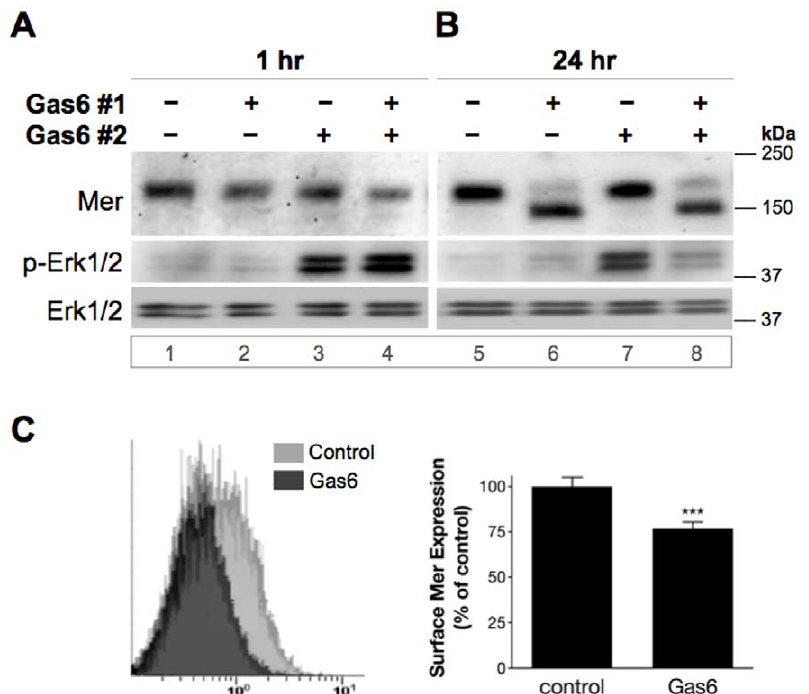
Figure 3. The Gas6-favored Mer glycoform is associated with altered downstream signaling and reduced surface expression. Jurkat cells were initially treated with 200 nM Gas6 ( + ) or control ( 2 ) for 1 hour ( A ) or 24 hours ( B ). After this first exposure ( Gas6 # 1 ), cells received a second dose of the same treatments, spiked in for 10 minutes ( Gas6 # 2 ), and were then lysed to evaluate expression of the indicated proteins by western blot (‘‘p-’’ represents a phosphorylated protein). Lane numbers are designated below blot images. Cells treated with vehicle only at the time of the second exposure ( lanes 1, 2 and 5, 6 ) displayed equally low levels of p-Erk1/2, indicating that basal levels of Erk activity had been restored since the time of initial Gas6 stimulation. ( C ) Surface expression of Mer was assessed by flow cytometry of Jurkat cells exposed to 200 nM Gas6 or vehicle control for 24 hours. Left: Representative histogram of Mer expression as a function of PE intensity ( x -axis). Right: MFI (median fluorescence intensity) values expressed as percent surface expression in Gas6-treated relative to control samples. Mean values and standard deviations (SD) derived from 5 independent experiments are shown (*** p , 0.0001, two-tailed unpaired t-test, 99% CI).